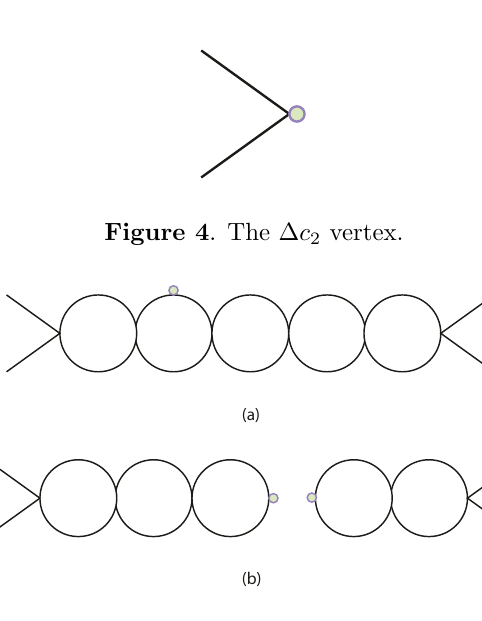
Figure 5 . (a) Insertions of the (cid:1) c 2 vertex in scattering diagrams are higher order in 1 =V 0 . (b) Diagrams like (cid:12)gure 5b are disconnected and do not contribute to scattering amplitudes. =